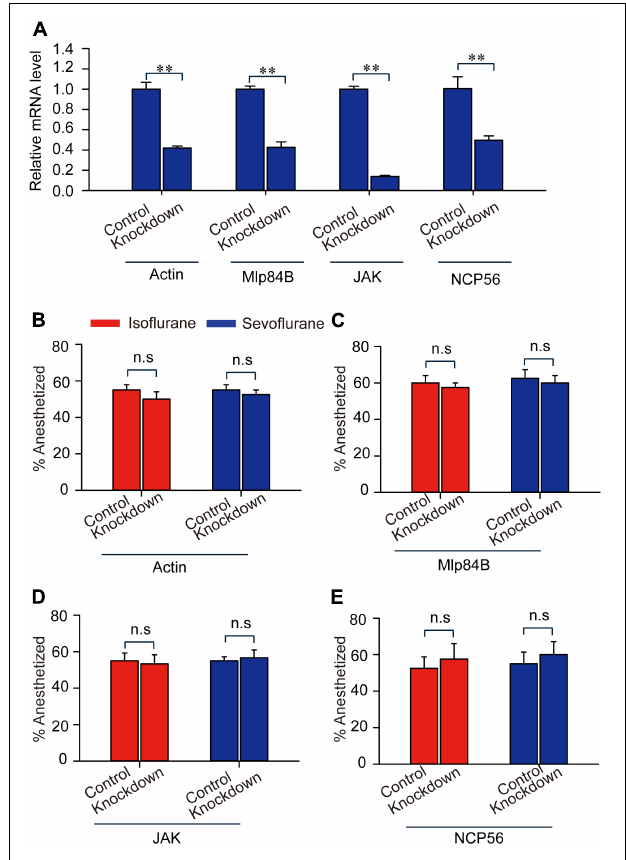
FIGURE 6 | Actin , Mlp84B , JAK and NCP56 do not affect anesthetic responses of the migratory locusts to isoflurane and sevoflurane. (A) The expression levels of Actin , Mlp84B , JAK and NCP56 mRNA are decreased significantly after RNAi knockdown ( n = 6 for each gene). (B–E) RNAi knockdown of Actin (B) , Mlp84B (C) , JAK (D) , and NCP56 (E) ( n = 40 for each treatment) do not affect the percentage of anesthetized locusts in response to isoflurane and sevoflurane, respectively. Student’s t -test is used for analyzing gene expression levels before and after RNAi knockdown, and anesthesia effects respectively. The percentage of anesthetized locusts is presented as mean ± SEM. n.s P > 0.05; ∗∗ P < 0.01. Mlp84B, Myosin-like protein 84B; NCP56, nymph cuticle protein 56; JAK, Janus